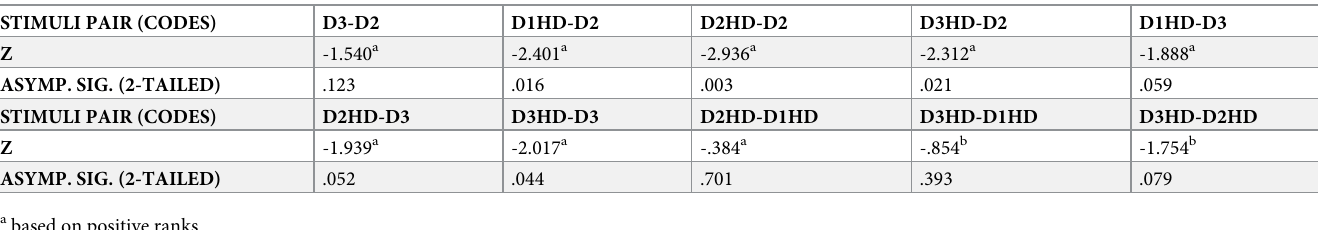
Table 4. Wilcoxon signed ranks test—task 1.